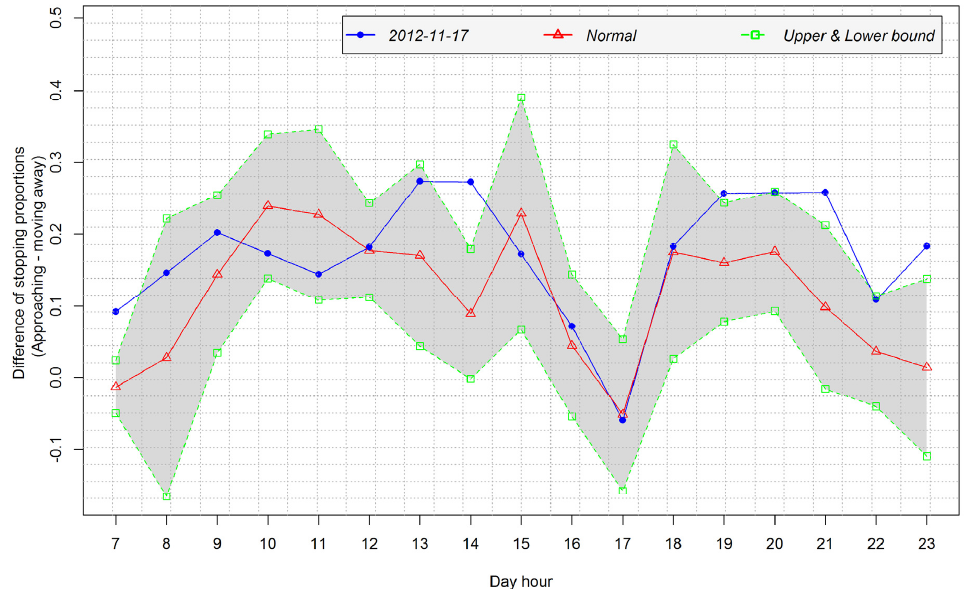
Figure 13. The variation of the balance of stoppings while approaching the event venue and stoppings while moving away on a day with an event.